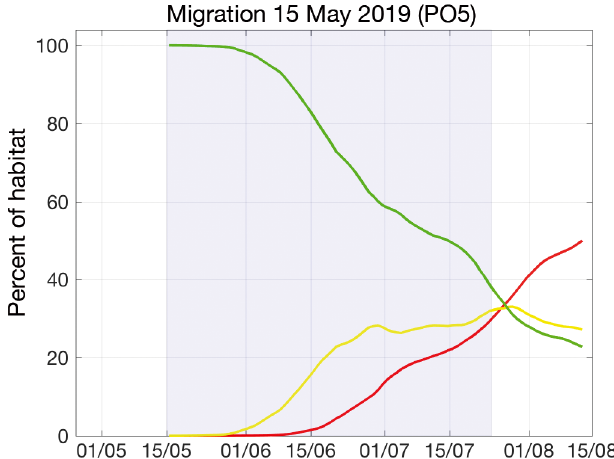
Fig. 4. Estimated percent of total marine living area in PO5 where sea trout smolt are likely to be infested with >18 mo- bile lice (red line), between 6 and 18 mobile lice (yellow line) and <6 mobile lice (green line). The blue shaded area indi- cates a period of 70 d starting on an intermediate migration date (May 15), the same period shown in Fig.